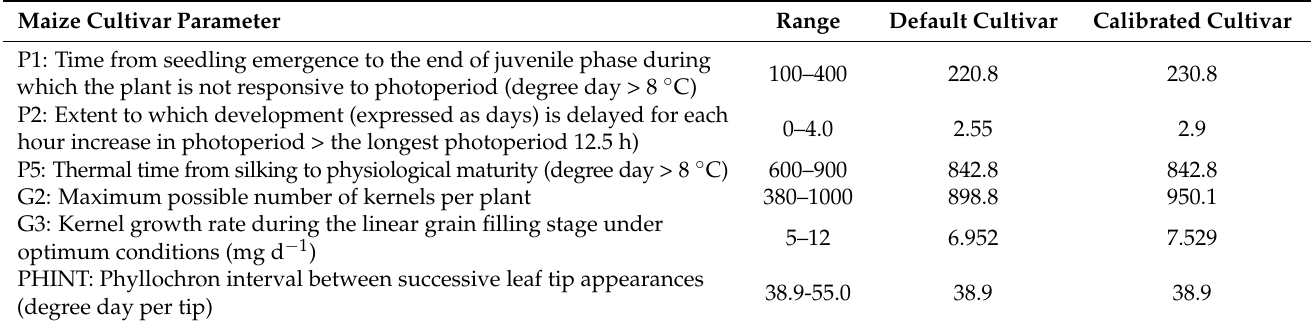
Table 2. Default cultivar coefficient ranges in the DSSAT model and calibrated cultivar coefficients for CT of